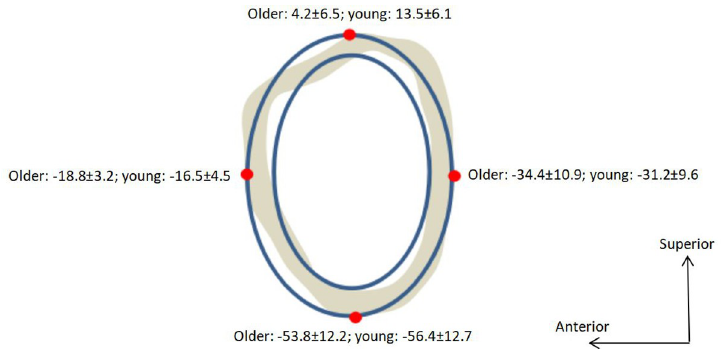
Fig 2. Elliptical bone model superimposed on a cross-sectional CT scan of the femoral neck, the 4-site stress values (in MPa) were shown during stair ascent at peak 1 for both older and young